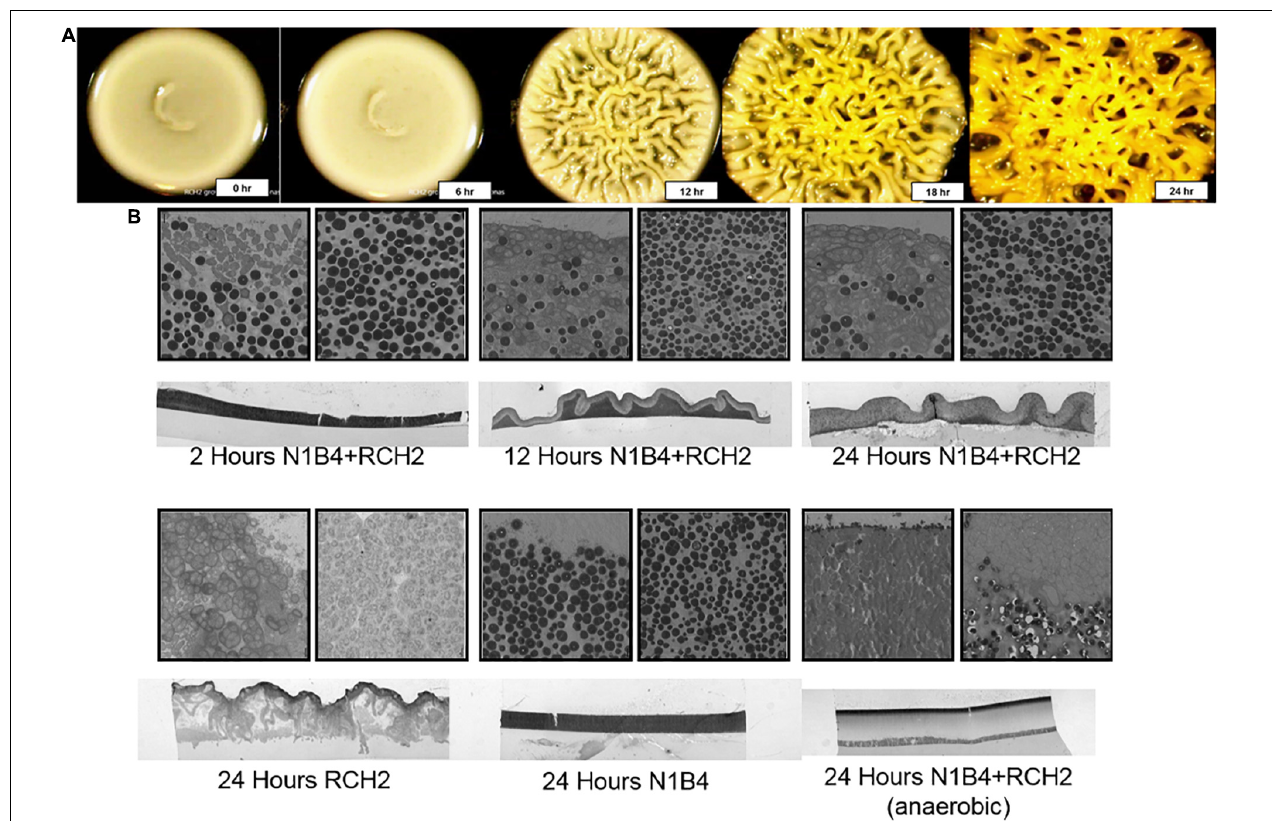
FIGURE 3 | Transmission electron microscopy of co-colony morphology. (A) Timepoint images of a co-colony of Pseudomonas sp. FW300-N1B4 (underlay) and Pseudomonas stutzeri RCH2 (overlay) were taken every 6 h for the first 24 h of the overlay culture. Control N1B4 cultures remain smooth (see Figure 4 and Supplementary Figure 2 ). (B) Transmission electron microscopy imaging (1,400 × ) of vertical slices showing the co-colony structure, air-colony interface, and strain interface were taken at 2, 12, and 24 h of aerobic RCH2 overlay culture, and at 24 h of an anaerobic RCH2 overlay culture. Similar imaging at 24 h of aerobic RCH2 and N1B4 monocultures were used to determine staining and morphology of each cell